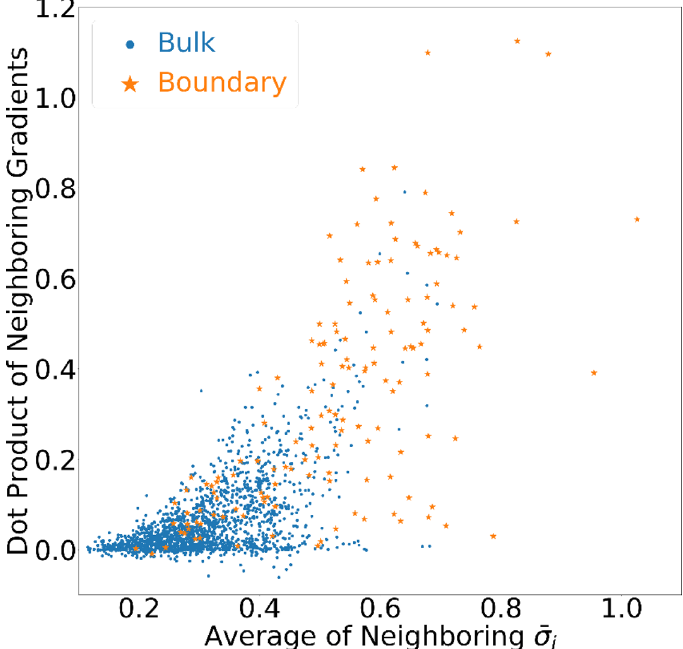
figure 12 — the relative standard deviation ( x -axis) and the dot product h ~G i α · h ~G i β of Delaunay- averaged gradients ( y -axis). The orange stars correspond to Delaunay edges D αβ whose midpoint is located close to the boundary ( 0 . 47 < x < 0 . 57 ), while blue circles represent the remaining edges further away. Since each Delaunay edge D αβ is dual to two Voronoi points P i and P j , the quantity shown on the x -axis is the average (¯ σ i + ¯ σ i ) / 2 of the respective relative standard deviations ¯ σ i and ¯ σ j